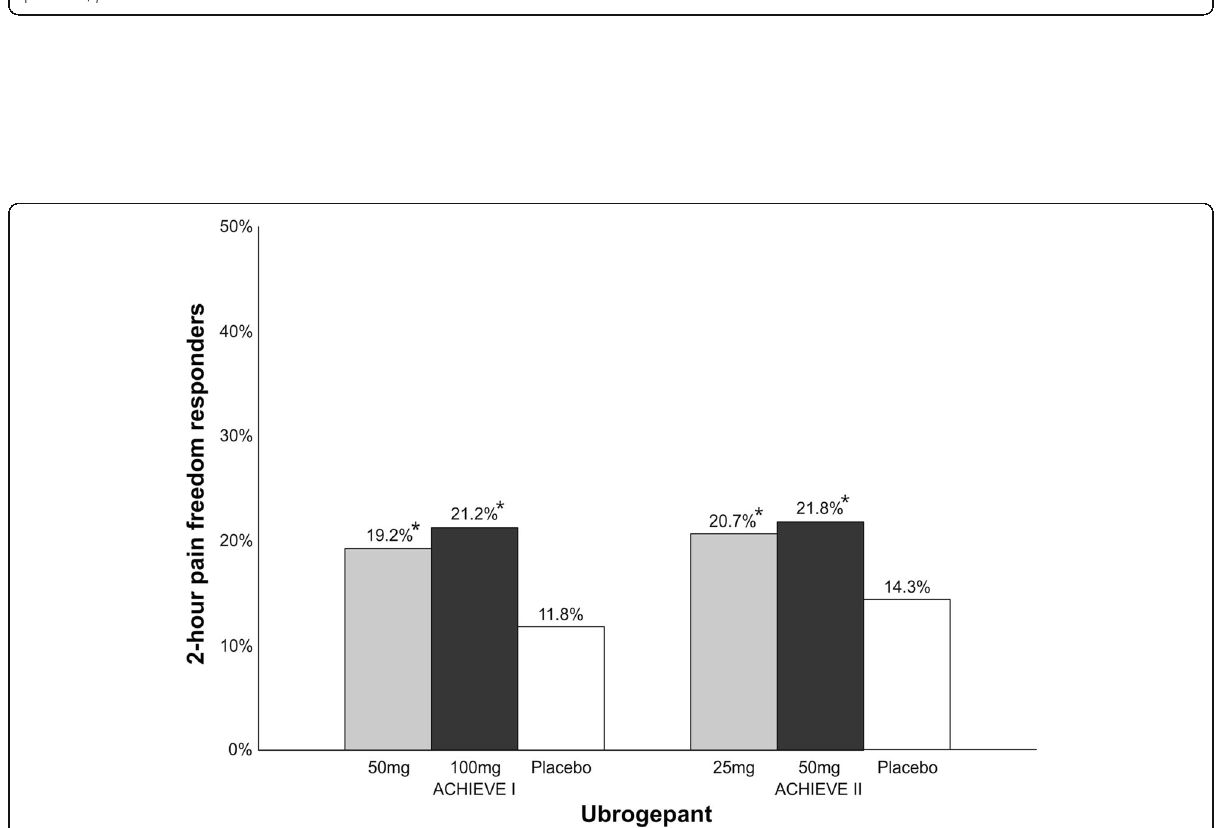
Fig. 5 Overview of patients (%) achieving 2-h pain freedom in ubrogepant phase III clinical trials. *ACHIEVE I; 50 mg vs. placebo, p = 0.0023; 100 mg vs. placebo, p = 0.0003. ACHIEVE II; 25 mg vs. placebo, p = 0.0285; 50 mg vs. placebo, p =